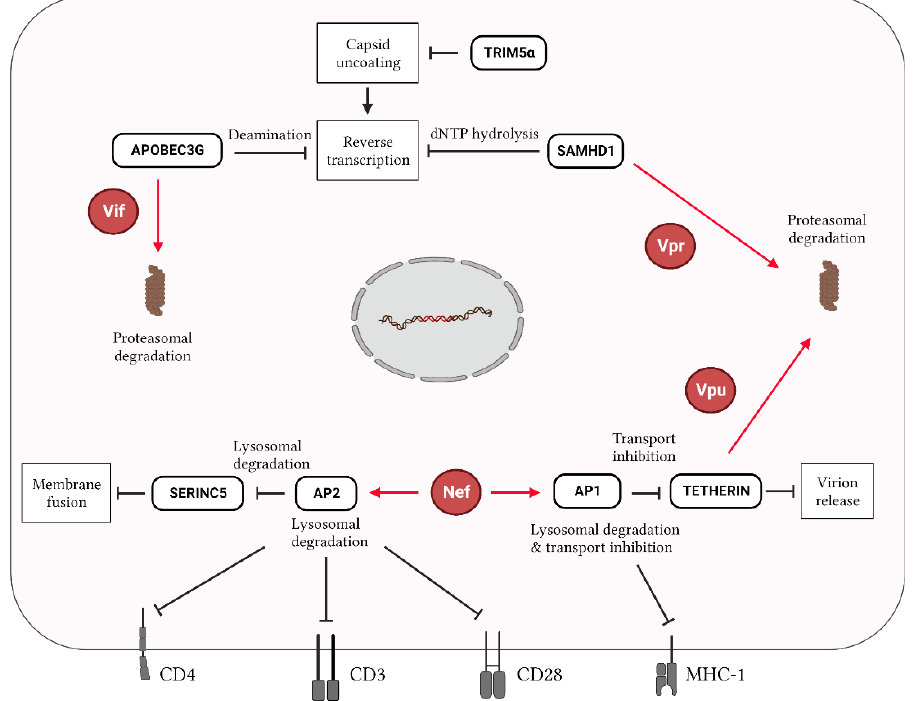
Figure 3. Interplay of host restriction factors and HIV proteins during infection. In HIV-infected cells, host restriction factors target several stages of the viral replication cycle. APOBEC3G, TRIM5α, and SAMHD1 restrict the reverse transcription of viral RNA, while SERINC5 and Tetherin affect HIV entry by reducing entry viral–cell membrane fusion and the HIV release of new virions, respectively. APOBEC3G, SAMHD1, and Tetherin are targeted for proteasomal degradation by Vif, Vpr and Vpu, respectively. Nef can stimulate the transcription factors AP1 and AP2 to further restrict the activity of Tetherin and SERINC5, respectively, as well as to downregulate the expression of the cell surface markers CD4, CD3, CD28, and MHC-1, thereby affecting immunity-related pathways. Red lines/arrows indicate functions exhibited by viral proteins, while black lines/arrows indicate functions exerted by host factors.